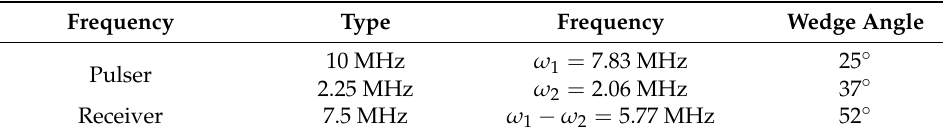
Table 5. Experimental conditions for guided wave mixing